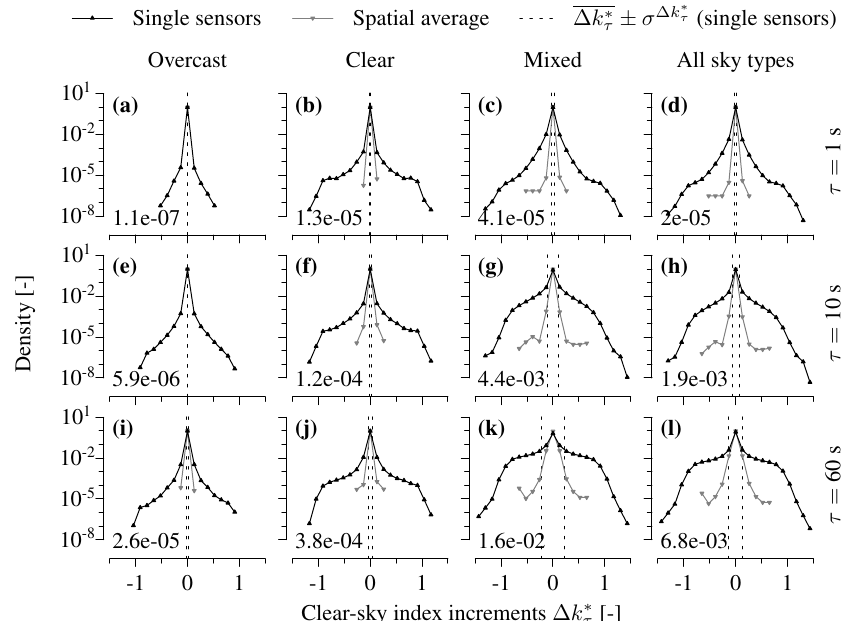
∗ Figure 5. Statistics of clear-sky index increments (cid:49)k τ for different time lags τ , based on data from the Jülich campaign. The first three columns display distributions conditioned on different sky types, while the rightmost column presents the combined statistics for all sky types. The estimated probability density functions of all single sensors (solid black lines) are supplemented with the range of ± 1 standard ∗ deviation σ (cid:49)k τ around their means (cid:49)k ∗ τ (dashed black lines), and contrasted to the much narrower distributions of the spatially smoothed average of all pyranometers (solid gray lines). The respective average probabilities P((cid:49)k ∗ τ = ± 0 . 5 ) of single sensors to fluctuate by ± 0.5 are quoted in each